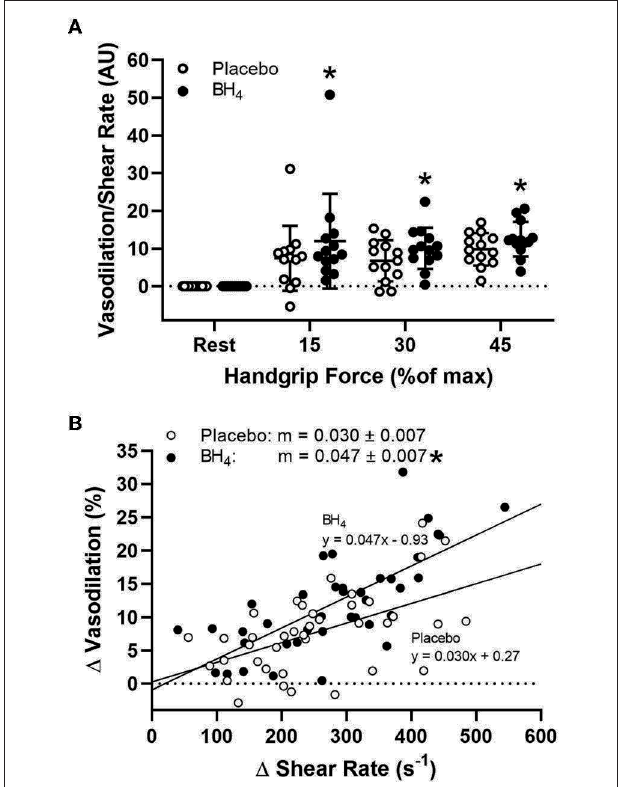
FIGURE 4 | Brachial artery vasodilation normalized to increases in shear rate (A) during progressive handgrip exercise in patients with systemic sclerosis after placebo (white circles) and tetrahydrobiopterin (BH 4 ; black circles). Brachial artery vasodilation to sustained increases in shear rate after placebo and BH 4 (B) . After acute BH 4 administration, patients with systemic sclerosis had a significantly higher slope (m) compared to placebo. * P < 0.05, significantly different than placebo. All data are presented as mean ±